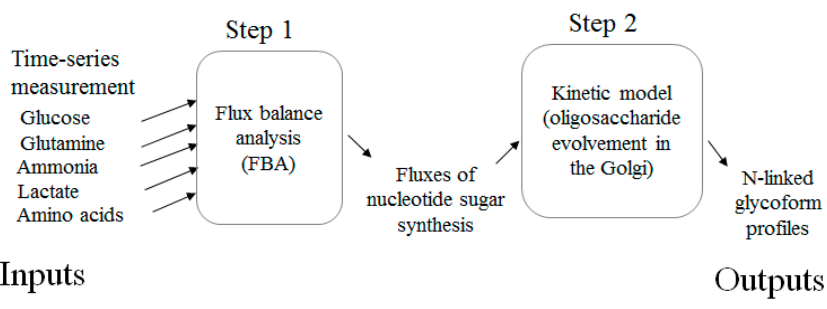
Figure 1. The workflow of two-component prediction model of glycoform profiles.